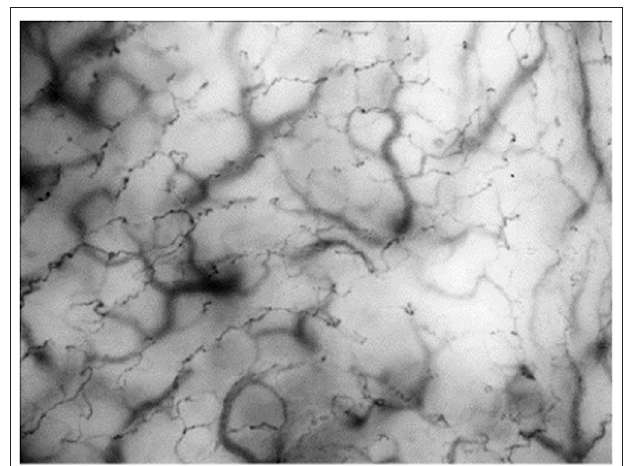
FIGURE 1 | Incident dark-field (IDF-) imaging of oral microcirculation in dogs using hand-held vital microscopy (HVM). Red blood cells are visualized as dark spots forming vessels through their axial migration. According to manufactures IDF-devices are able to register a field of view with 1.55 × 1.16mm. Oral microcirculation is shown with an additional magnification factor of